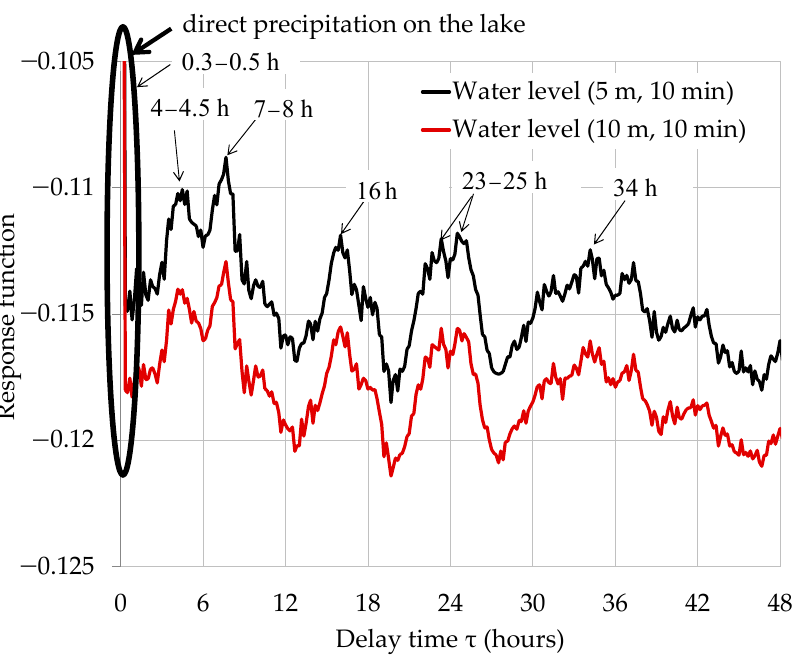
Figure 3. Calculated water-level response functions with respect to average precipitation from 24 June to 17 July 2018, showing τ < 48 h. These functions were calculated using MATLAB software, and the figure was drawn using Microsoft Excel.